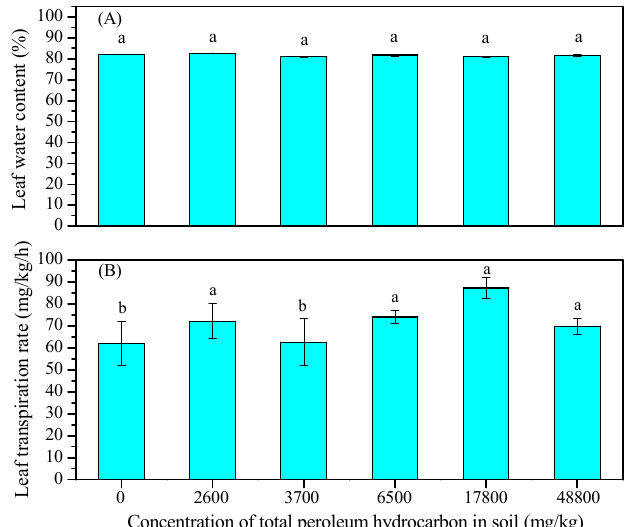
Figure 3. Effect of soil contamination with crude oil on water content ( A ) transpiration rate ( B ) of maize leaf ( p < 0.05). Different letters on top of the bar indicate they are significantly different at p < 0.05.